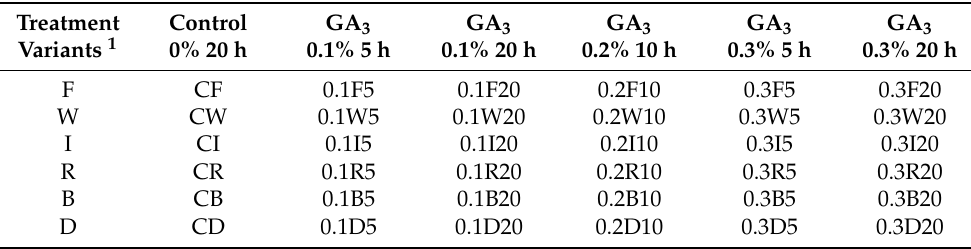
Table 1. Treatment variants tested for in vivo seed germination of P. veris : codes show the factors tested (light and pretreatment with solutions of GA 3 ) and their